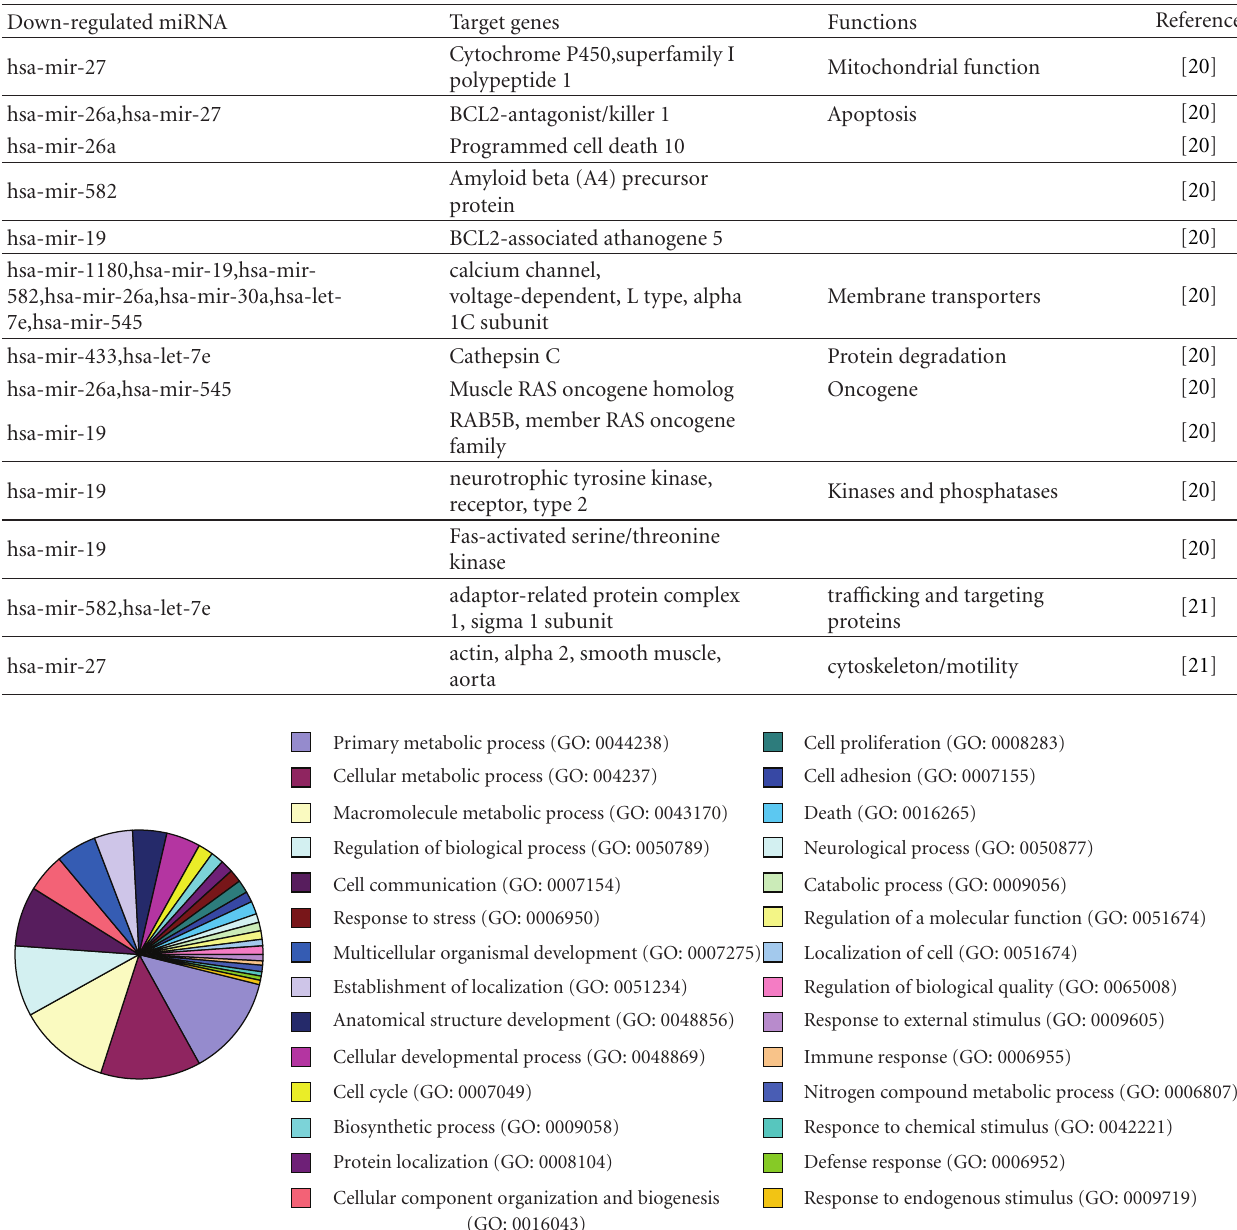
Table 5: Reverse regulatory association of down-regulated miRNAs and their predicted mRNA targets.